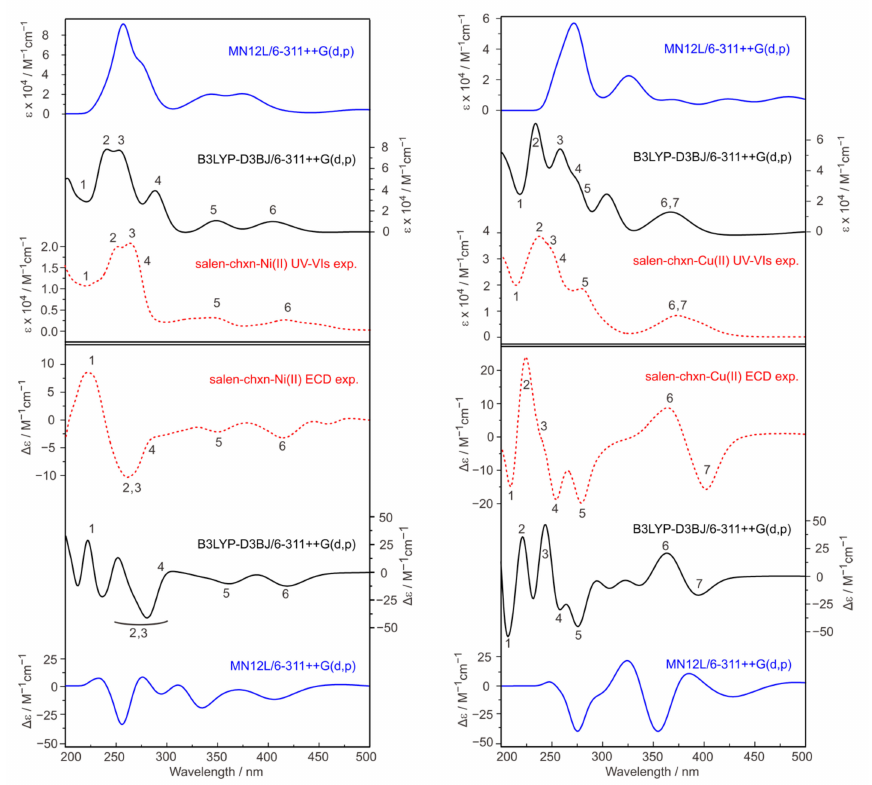
Figure 10. Comparison of the experimental and simulated UV-Vis ( top ) and ECD ( bottom ) spectra of salen-chxn-Ni(II) and salen-chxn-Cu(II) at two different levels of theory. In total, 250 electronic states were included in the calculation. The main UV-Vis and ECD bands of salen-chxn-Ni(II) and salen-chxn-Cu(II) are labelled as “1” to “6” and “1” to “7”, respectively, to aid the